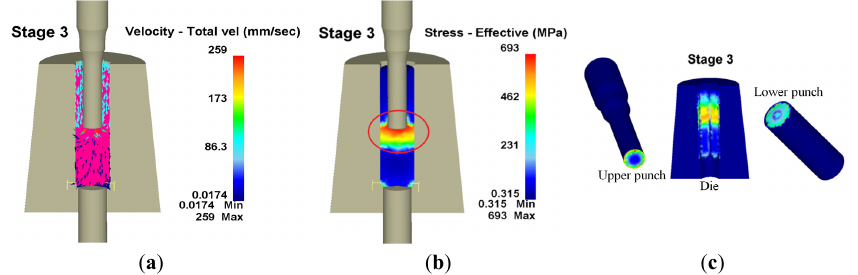
Figure 11. Velocity, effective stress and wear distribution of the third stage in 3D. ( a ) Velocity; ( b ) Effective stress; ( c ) Wear.